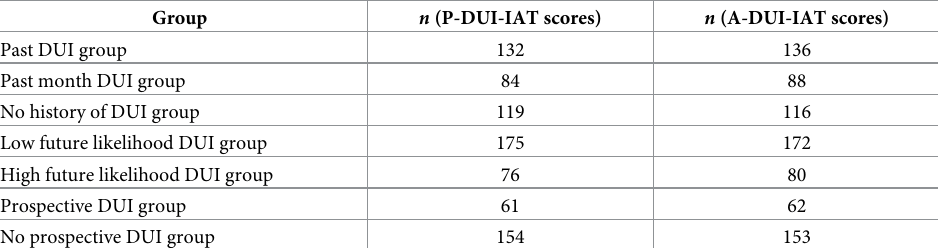
Table 4. Number of participants per DUI group and IAT type Study